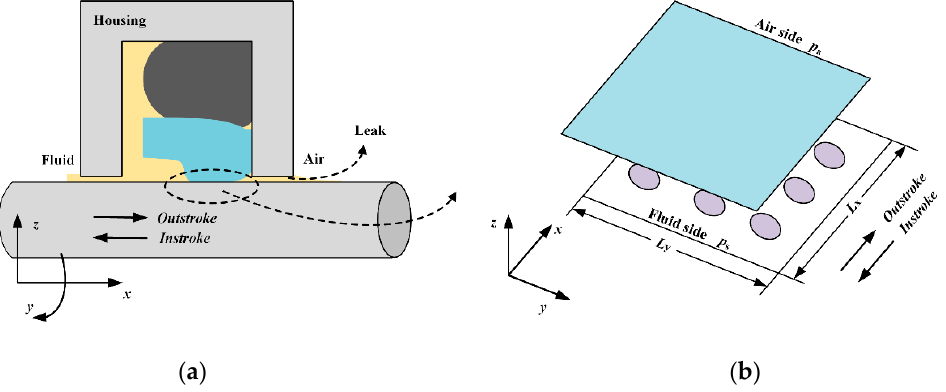
Figure 3. ( a ) Structure of reciprocating seal [31]; ( b ) Cartesian coordinate system on sealing zone.